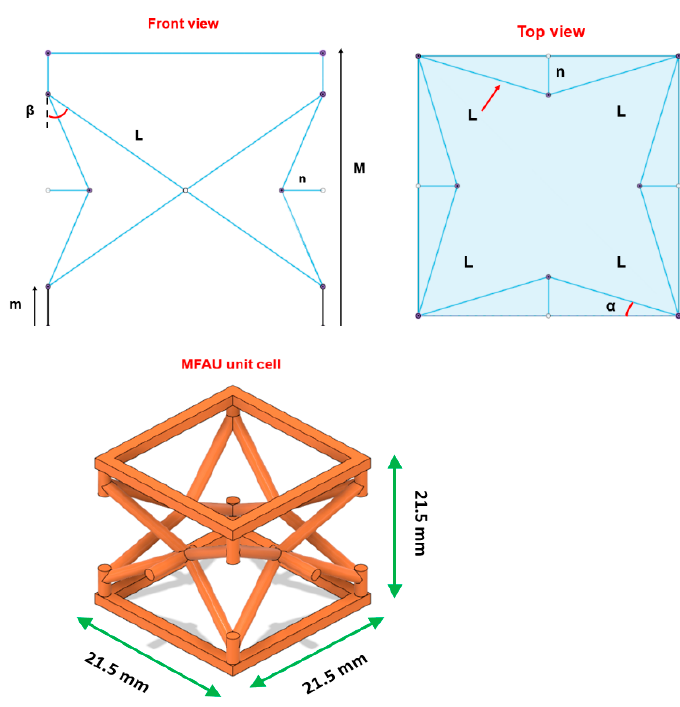
Figure 2. Schematic design of a meta-functional auxetic unit cell.